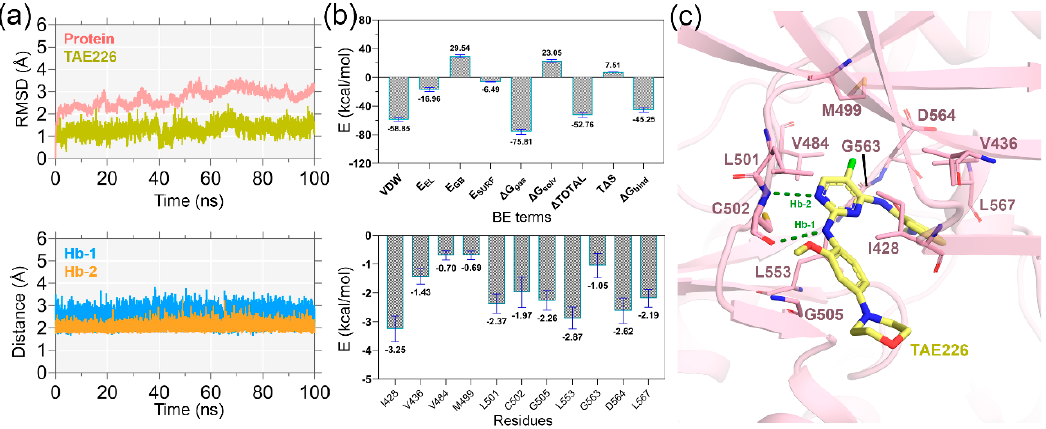
Figure 1. MD simulation and MM-PB/GBSA binding energy calculation. ( a ) RMSD analysis of the protein backbone and TAE226 during 100 ns of MD simulation. The distances of the two intermolecular H-bonds (Hb-1 and Hb-2) with the carbonyl and amide groups of C502 are shown during the MD run. ( b ) Binding affinity calculation and residue-specific binding energy decomposition from the MM-PB/GBSA calculation. ( c ) Residues within 4 Å distance of the TAE226 atoms, that contribute critical binding energy to the ligand, are shown in the stick representation.